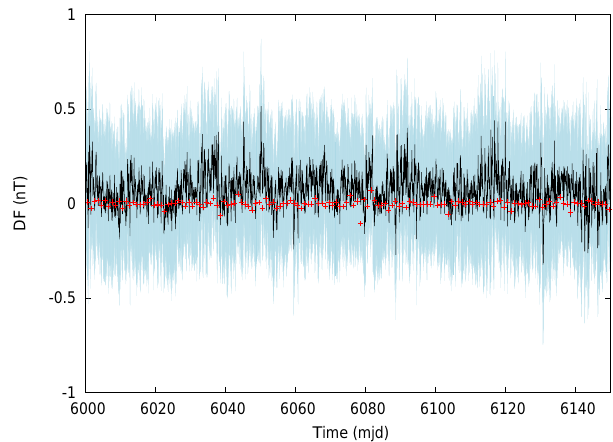
Figure 5. Estimates of the (cid:49)F values (see Eq. 4) for 150 days in 2016. In black is one (cid:49)F value per hour, in light blue is their 1 σ interval, and in red are the (cid:49)F values that have been minimised during the optimisation process leading to the baseline